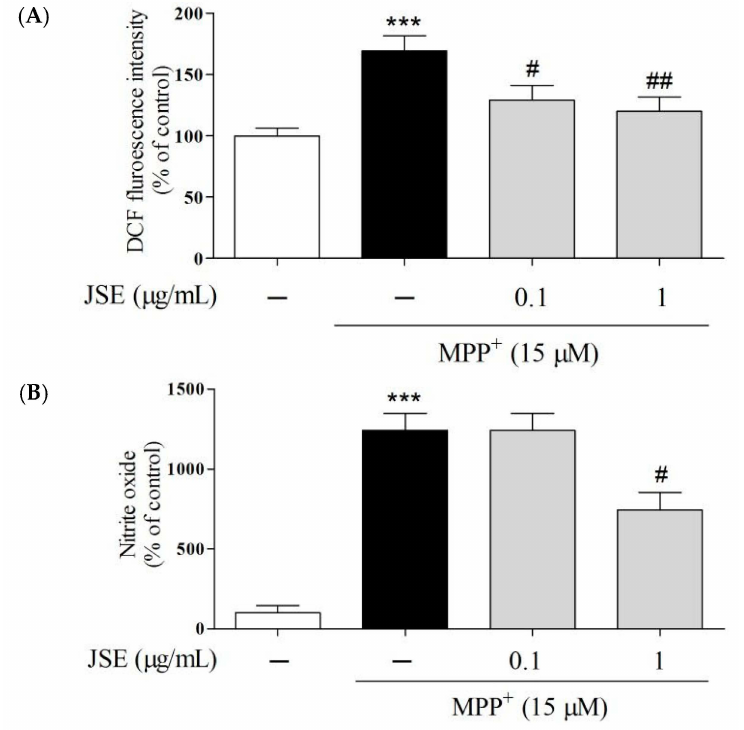
Figure 3. Effect of JSE on MPP + -induced ROS and NO generations in vitro . 2,7-dichlorofluorescein (DCF) fluorescence intensity was measured after exposure of primary mesencephalic cells to 15 µ M 1-methyl-4-phenylpyridinium (MPP + ) for 1 h, followed by 25 µ M 2,7-dichlorodihydrofluorescein diacetate (H 2 DCF-DA) for 30 min ( A ); Extracellular NO production in JSE-pretreated (23 h) primary mesencephalic cells before 15 µ M MPP + treatment was assayed by measuring NO in the supernatant using the Griess reagent ( B ). Values were expressed as means ˘ SEM. *** p < 0.001 vs. the control group; # p < 0.05 and ## p < 0.01 vs. the MPP + -only treated